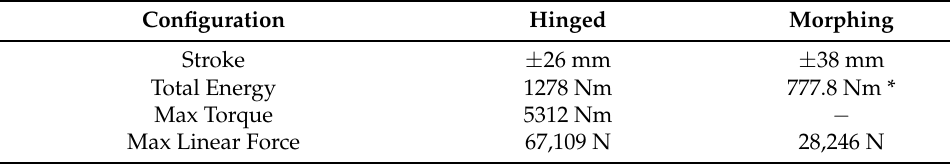
Table 2. Comparison between hinged/morphing actuation system